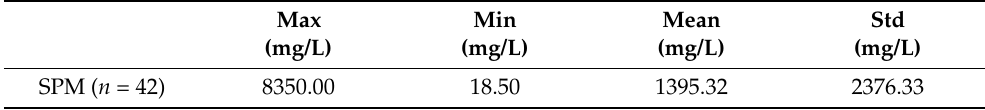
Table 1. Statistical characteristics of SPM